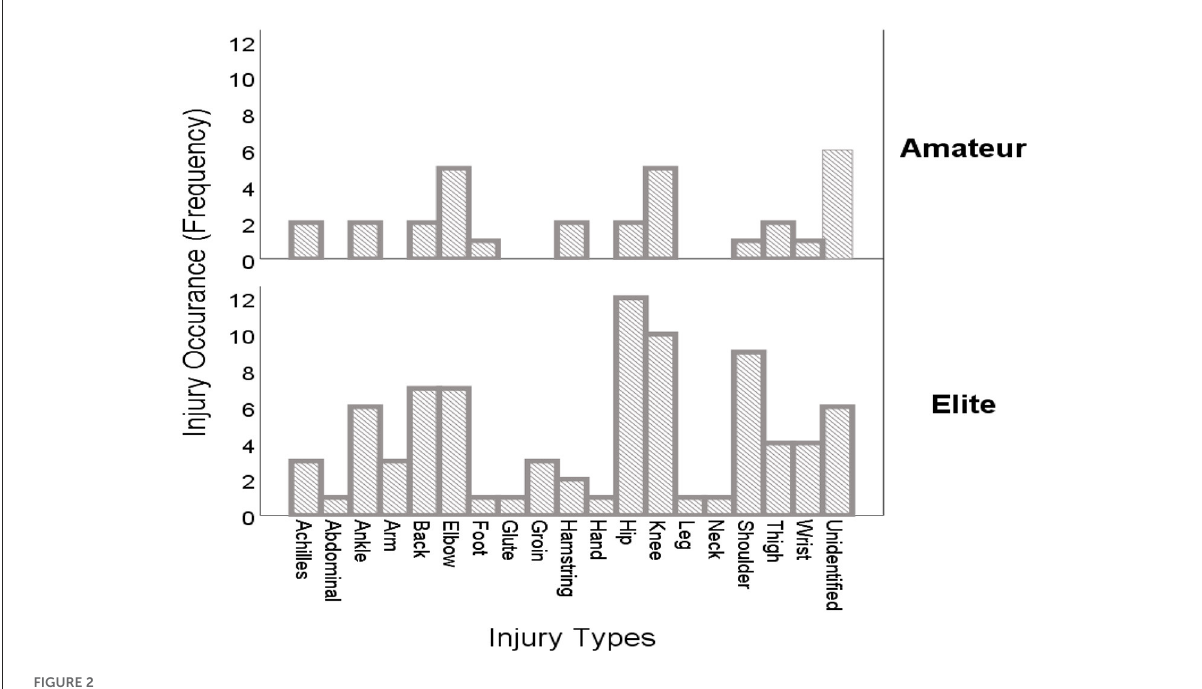
FIGURE2 Injury occurrences among elite and amateur players.